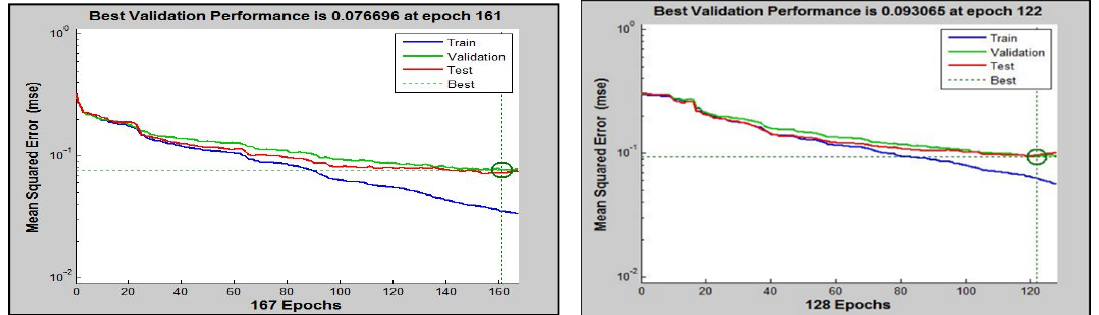
Figure 18. Network learning curve for the structure of 4 ‐ 21 ‐ 3 for 167 epochs.